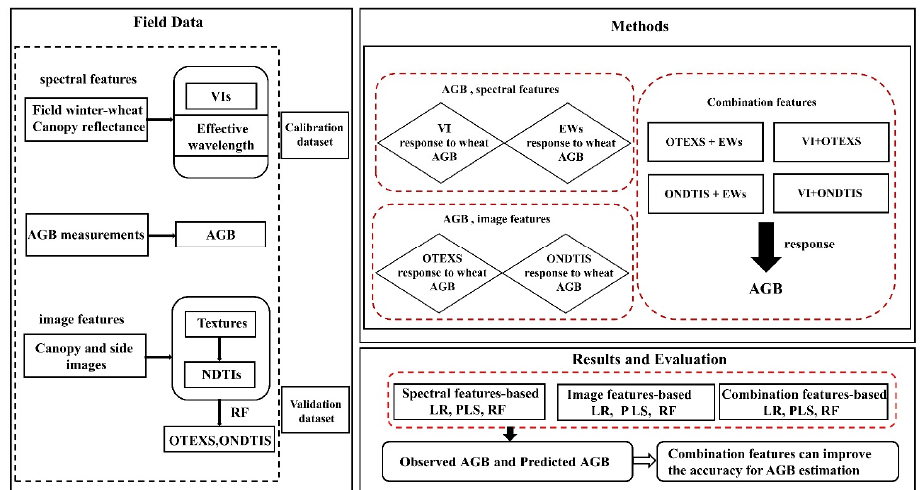
Figure 3. Experiment methodology.